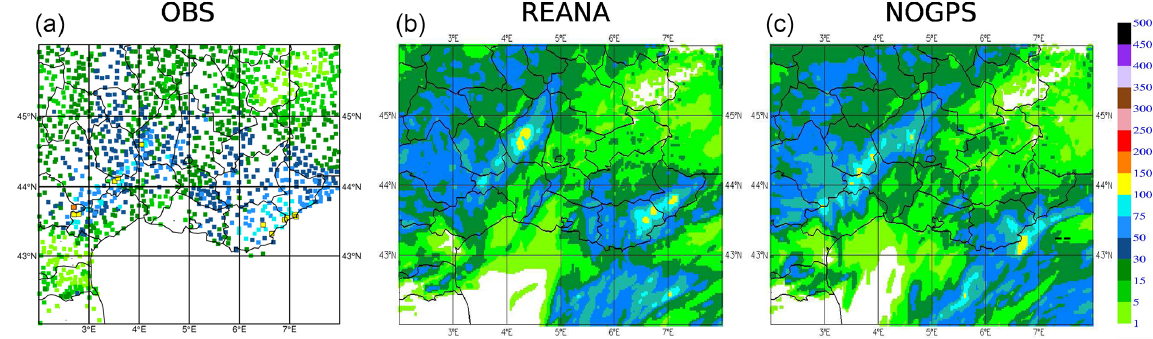
Figure 9. The 24h accumulated precipitation (mm per 24h) between 06:00UTC on 26 October and 06:00UTC on 27 October 2012 over southern France (zoom over the Cévennes area); observations (a) , REANA (b) , and NOGPS (c)